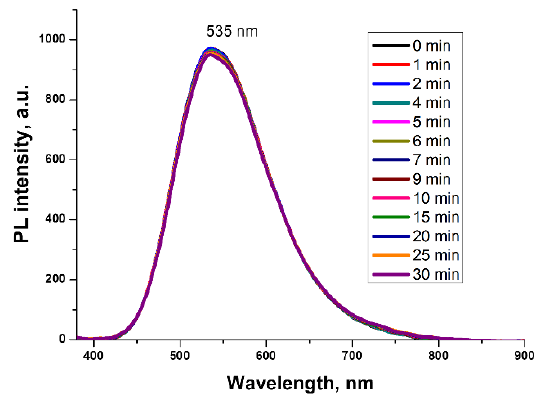
Figure 5. PL spectra of (H 3 BO 3 +8-Hq) solution in TGF, depending on the exposure time at 30 °C (λ ext = 365 nm).